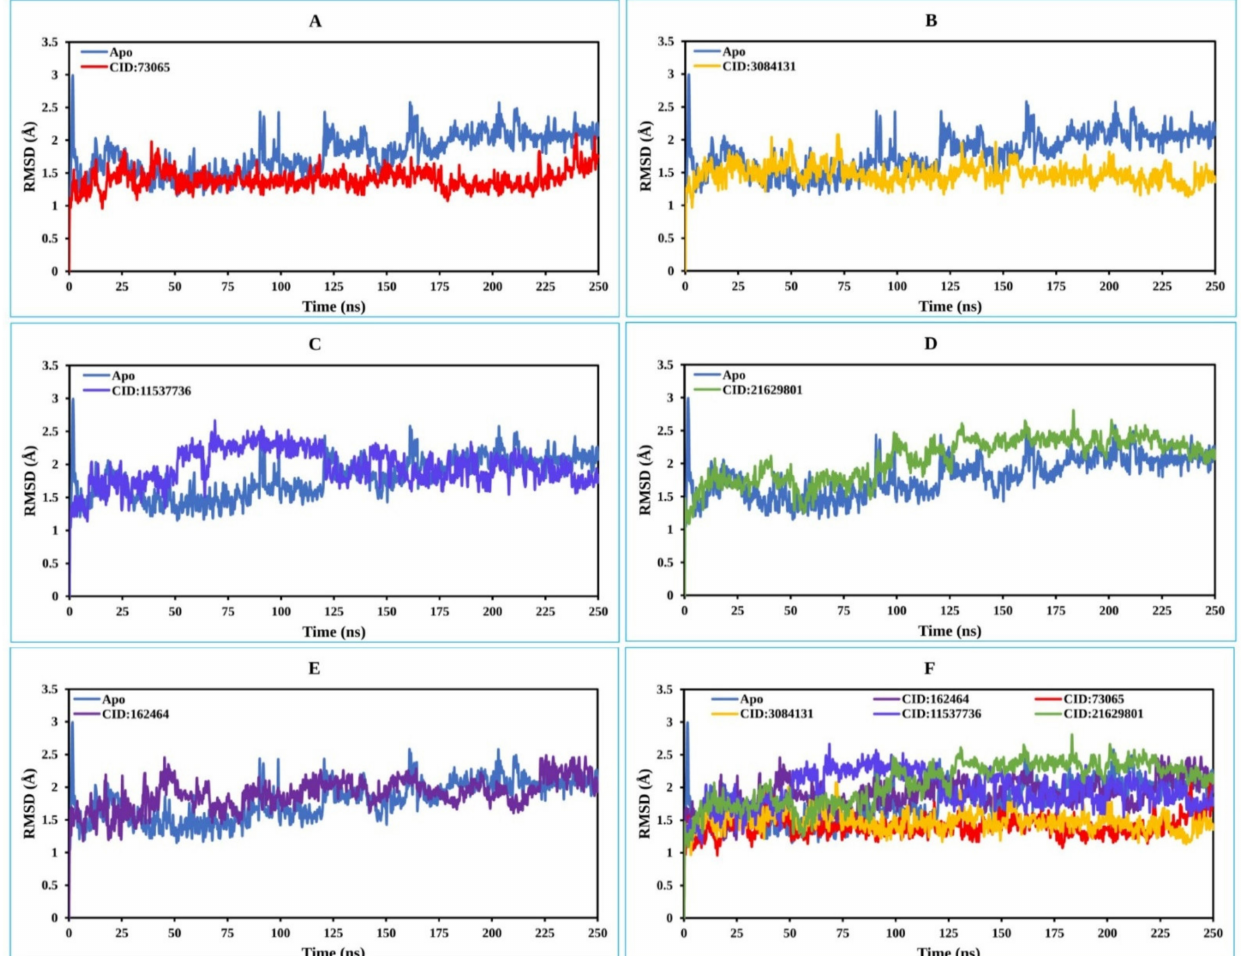
Figure 4. The RMSD values extracted for the C α atoms of the five selected compounds in complex with the MCPyV LT protein (blue) for the compounds ( A ) CID: 73065 (red), ( B ) CID: 3084131 (yellow), ( C ) CID: 11537736 (light blue), ( D ) CID: 21629801 (green), and ( E ) CID: 162464 (purple), and ( F ) shows all the RMSD for all compounds and the protein